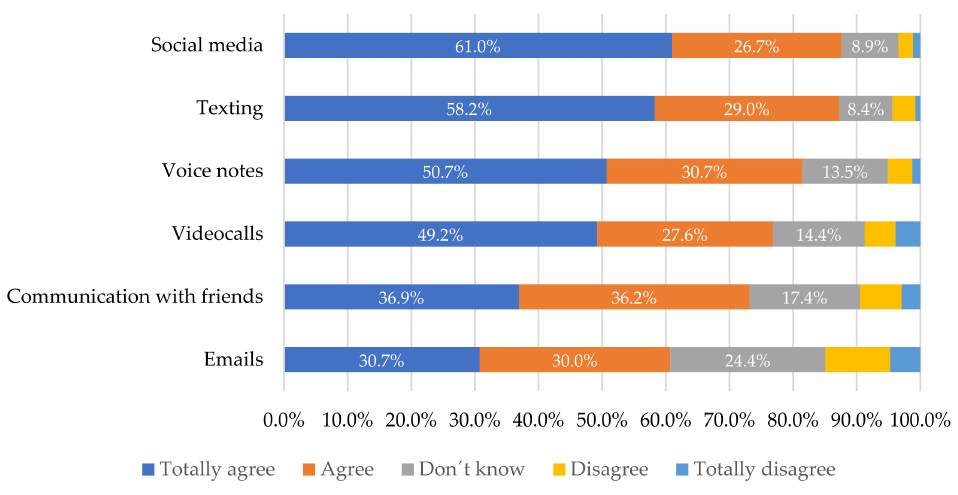
Figure 4. Distribution of percentages of responses to situations that have increased due to the COVID-19